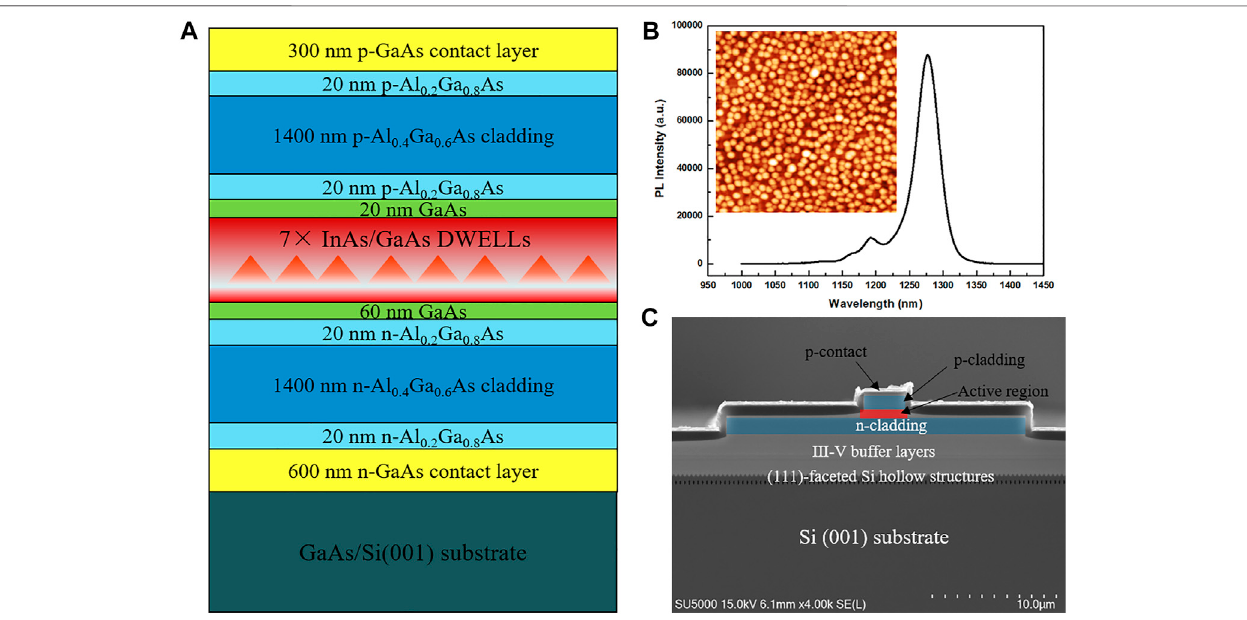
FIGURE1|(A) TheschematicdiagramofthewholeInAs/GaAsQDlaserstructureontheGaAs/Si(001)substrate. (B) Room-temperaturePLspectrumofa7-layer InAs/GaAsDWELLstructuregrownontheGaAs/Si(001)substrate.Inset:1 × 1 μ m 2 AFMimageofuncappedInAs/GaAsQDsontheGaAs/Si(001)substrate. (C) Color- enhanced cross-sectional SEM image of a fabricated ridge laser on the Si (001) substrate, with a ridge width of 4 μ m.